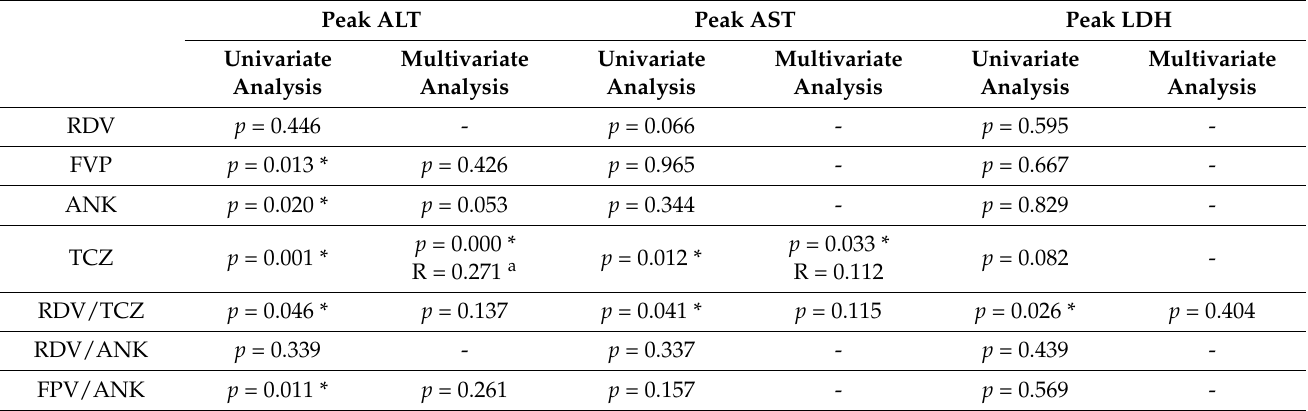
Table 4. Correlations between hepatocellular injury and COVID-19 therapy. Peak ALT Peak AST Peak